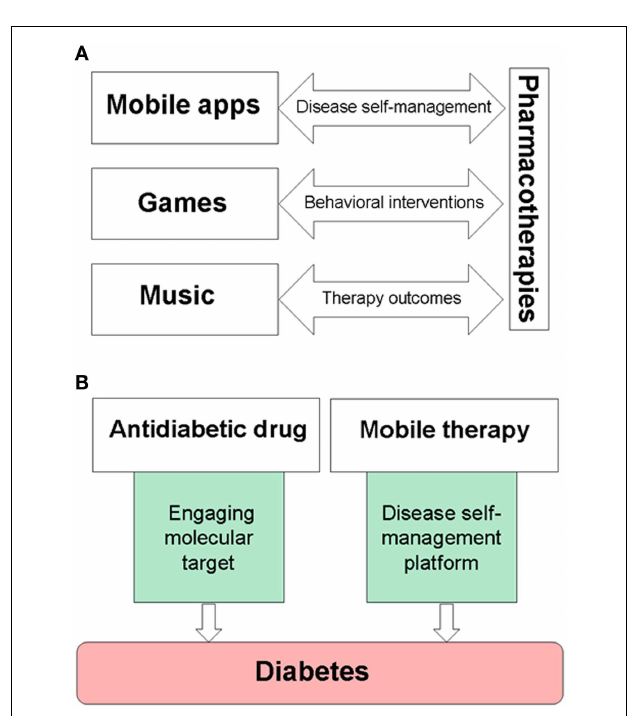
FIGURE 1 | Examples of drug–device interfaces created by mobile medical applications, serious video games, or music . (A) Electronic devices are used to provide music, games, and mobile medical applications, while also becoming delivery systems for disease self-management platforms. (B) An example of combining pharmacotherapies with medical devices for the treatment of diabetes. Mobile therapies, such as BlueStar®, can support disease-specific, healthy behaviors of a patient, and remind about taking prescribed medications on-time.